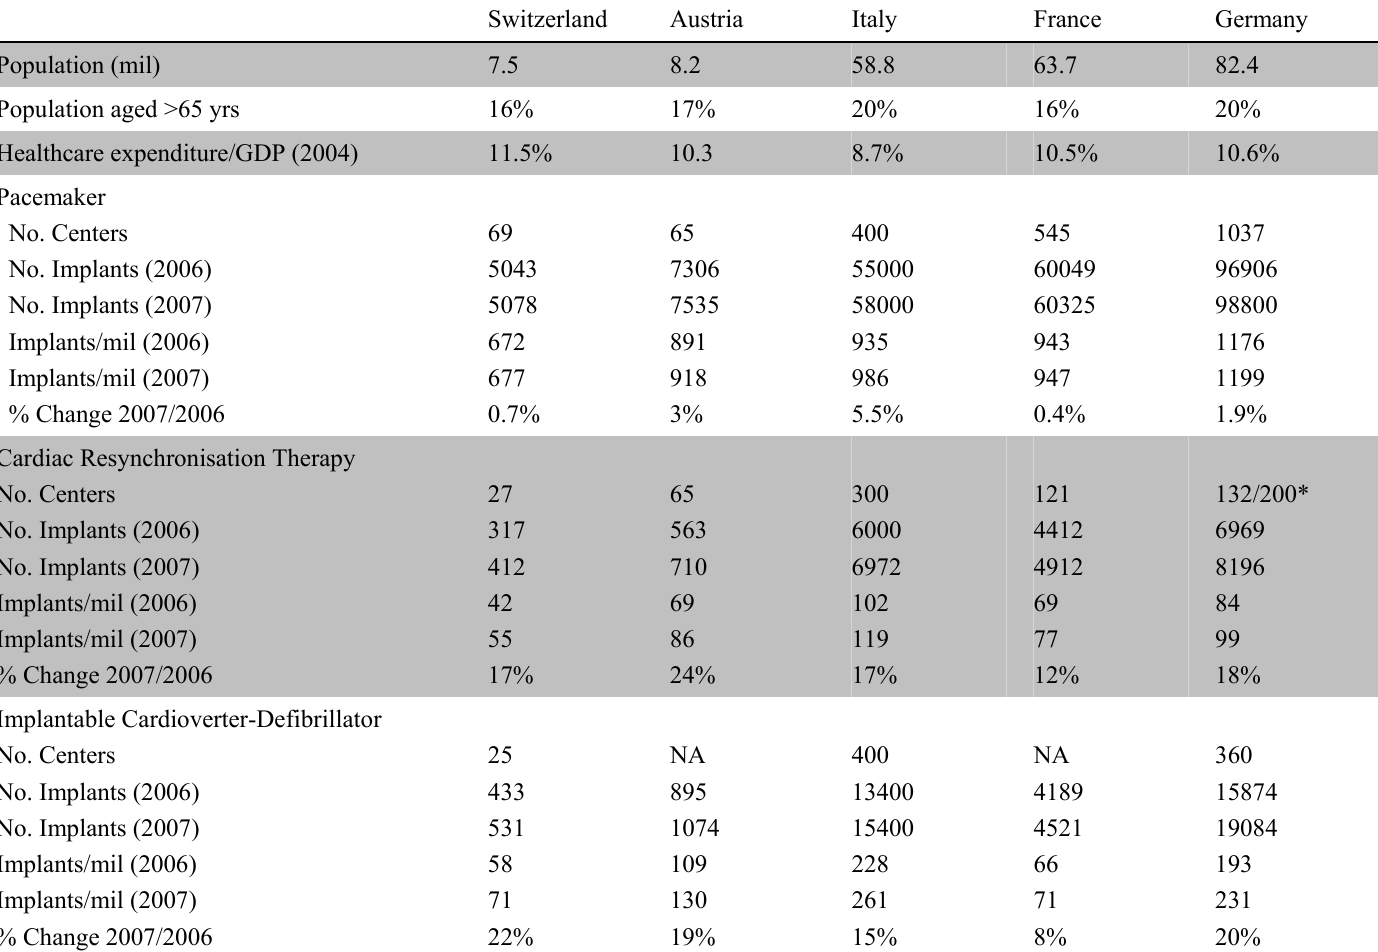
Table 2 Selected demographic information and number of device implantations in Switzerland and surrounding countries for the years 2006 and 2007, as recorded by the European Heart Rhythm Association White Book